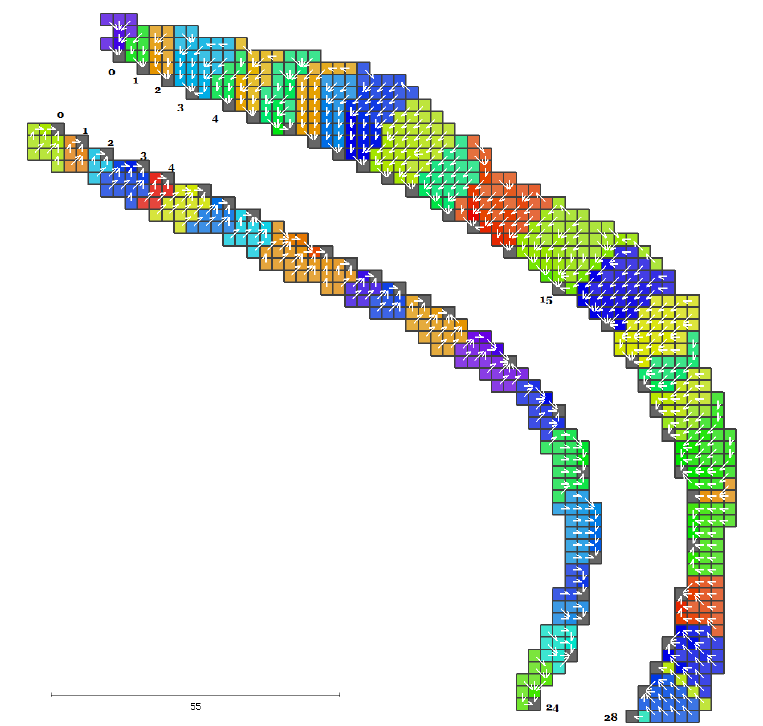
Figure 9: Labelled roadside catchment area